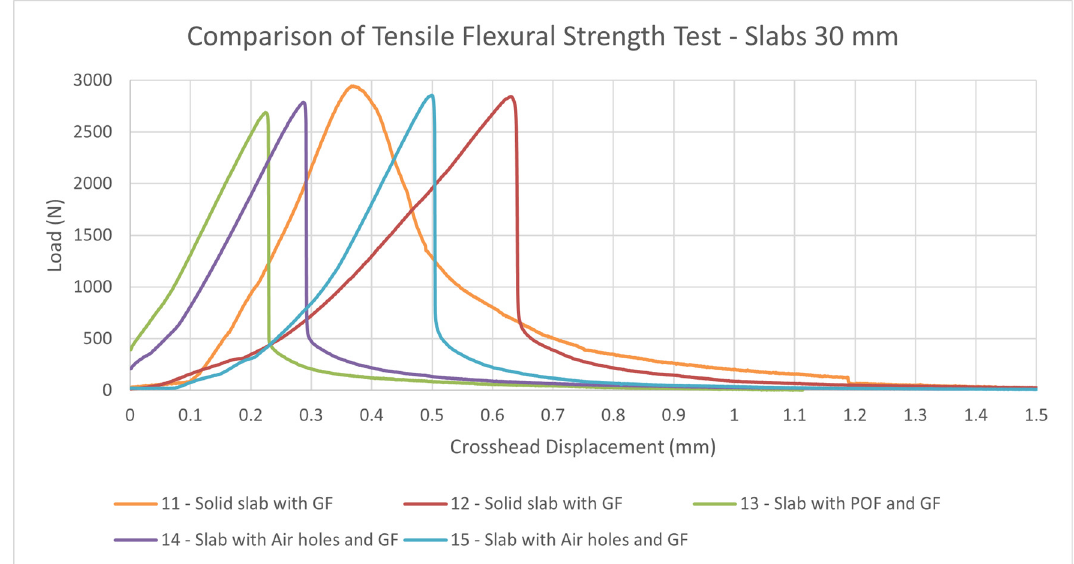
Figure 41. Comparison of tensile flexural strength test of slabs of thickness 30 mm.